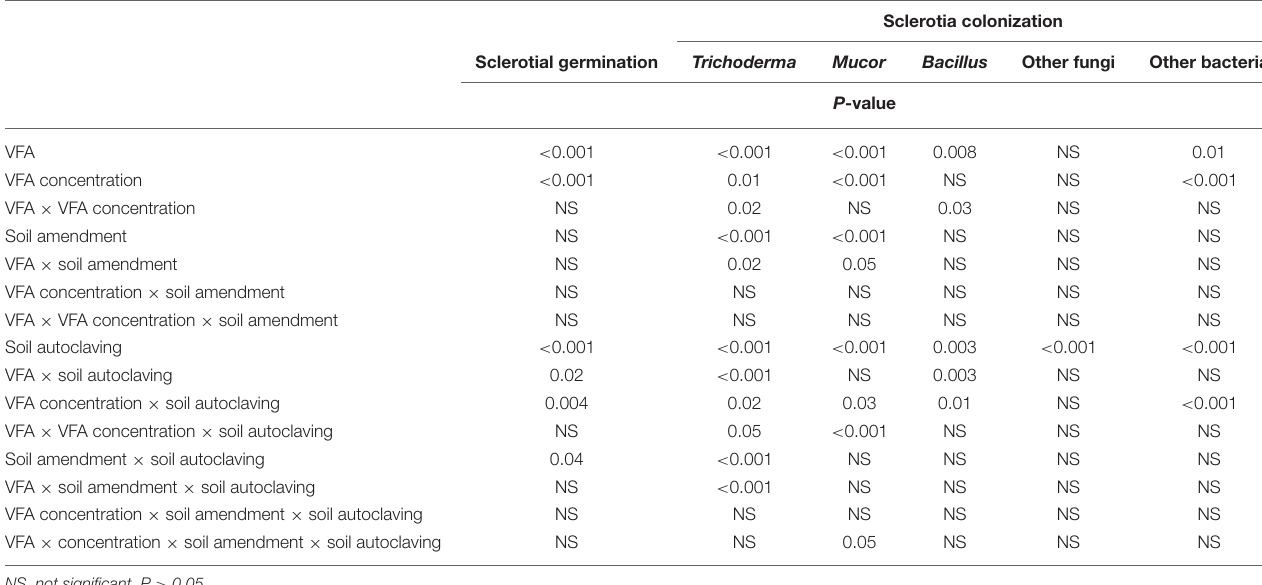
TABLE 1 | Analysis of variance of the response variables percentage germination of Athelia rolfsii sclerotia and percentages colonization of sclerotia by soil fungi and bacteria in experiment 1 as affected by the main effects of volatile fatty acid (VFA) type, VFA concentration, ASD soil amendment, soil autoclaving, and their interactions.